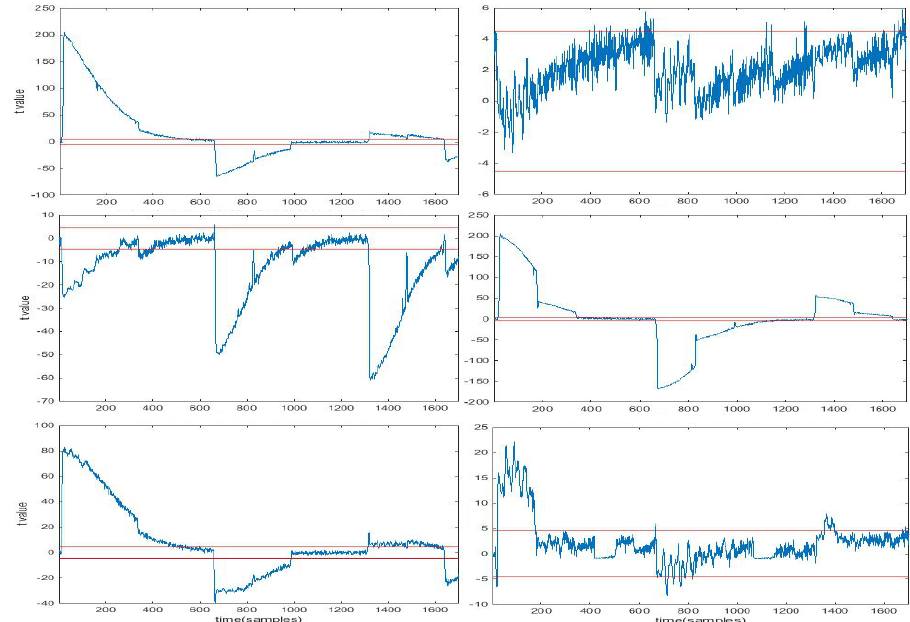
Figure 2: TVLA on our first-order DOM- Keccak implementation. Left: Masks off with 20k measurements. Right: masks on with 55M measurements. From top to bottom: first-, second-, and third-order analysis